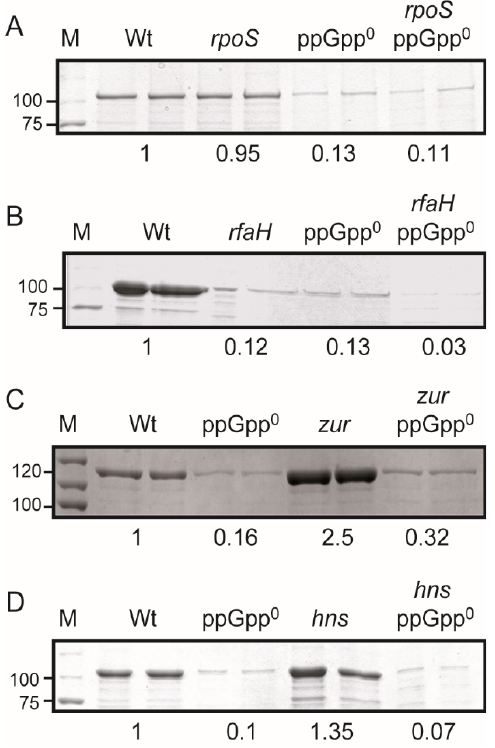
Figure 4. ppGpp-mediated stimulation of hlyCABD II expression is independent of RpoS, RfaH, and H-NS. Electrophoretic analyses (Coomassie blue stained 10% SDS-PAGE) of cell-free bacterial culture supernatants of ppGpp-proficient and ppGpp-deficient derivatives of rpoS ( A ), rfaH ( B ), zur ( C ), and hns ( D ) and its corresponding Wt counterparts (AAG1/pSF4000 for rpoS and hns analyses and AAG1/pMGP-1 for rfaH and zur analyses). Cultures were grown in LB at 37 °C up to late exponential phase (OD 600nm of 0.8). Lane M: molecular mass markers (size in kDa indicated along the left side). The relative average intensity of the bands is indicated at the bottom of the panel.